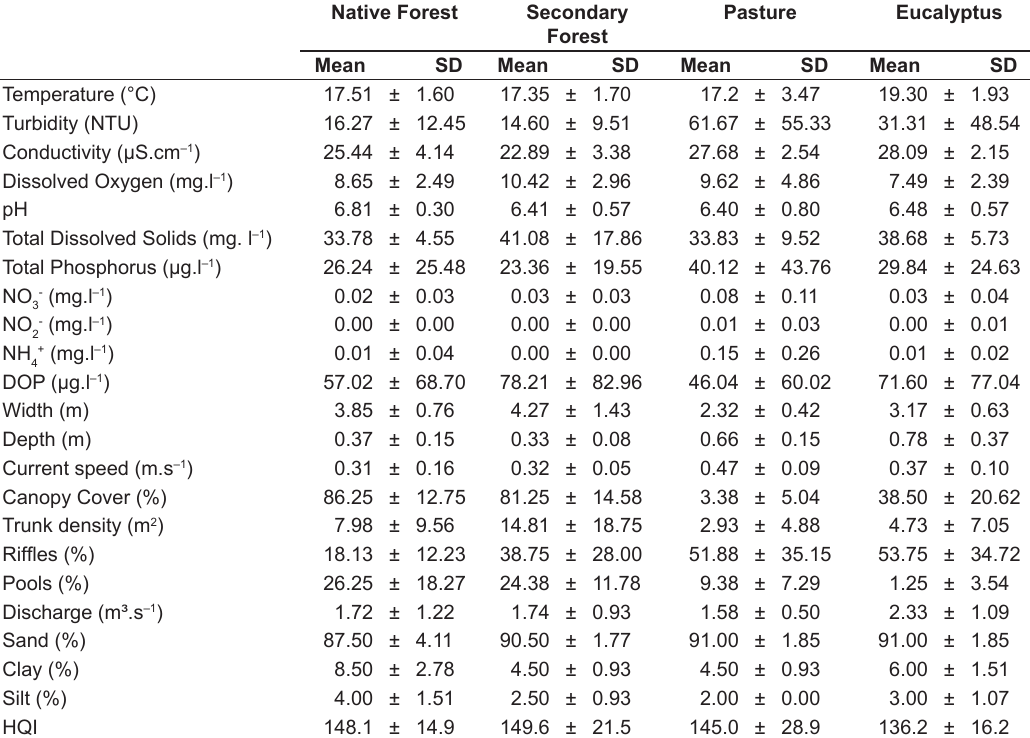
Figure 2. Total monthly rainfall and average monthly discharge of the Paraitinga River for the period of March 2004 to March 2005. Data obtained at DAEE Station no 2E-0046. Table 1. Water quality and habitat structure (mean and standard deviation, considering the dry and rainy seasons) for the different riparian conditions (n= 8) along the Paraitinga River. DOP – dissolved organic phosphorus; HQI – Habitat quality